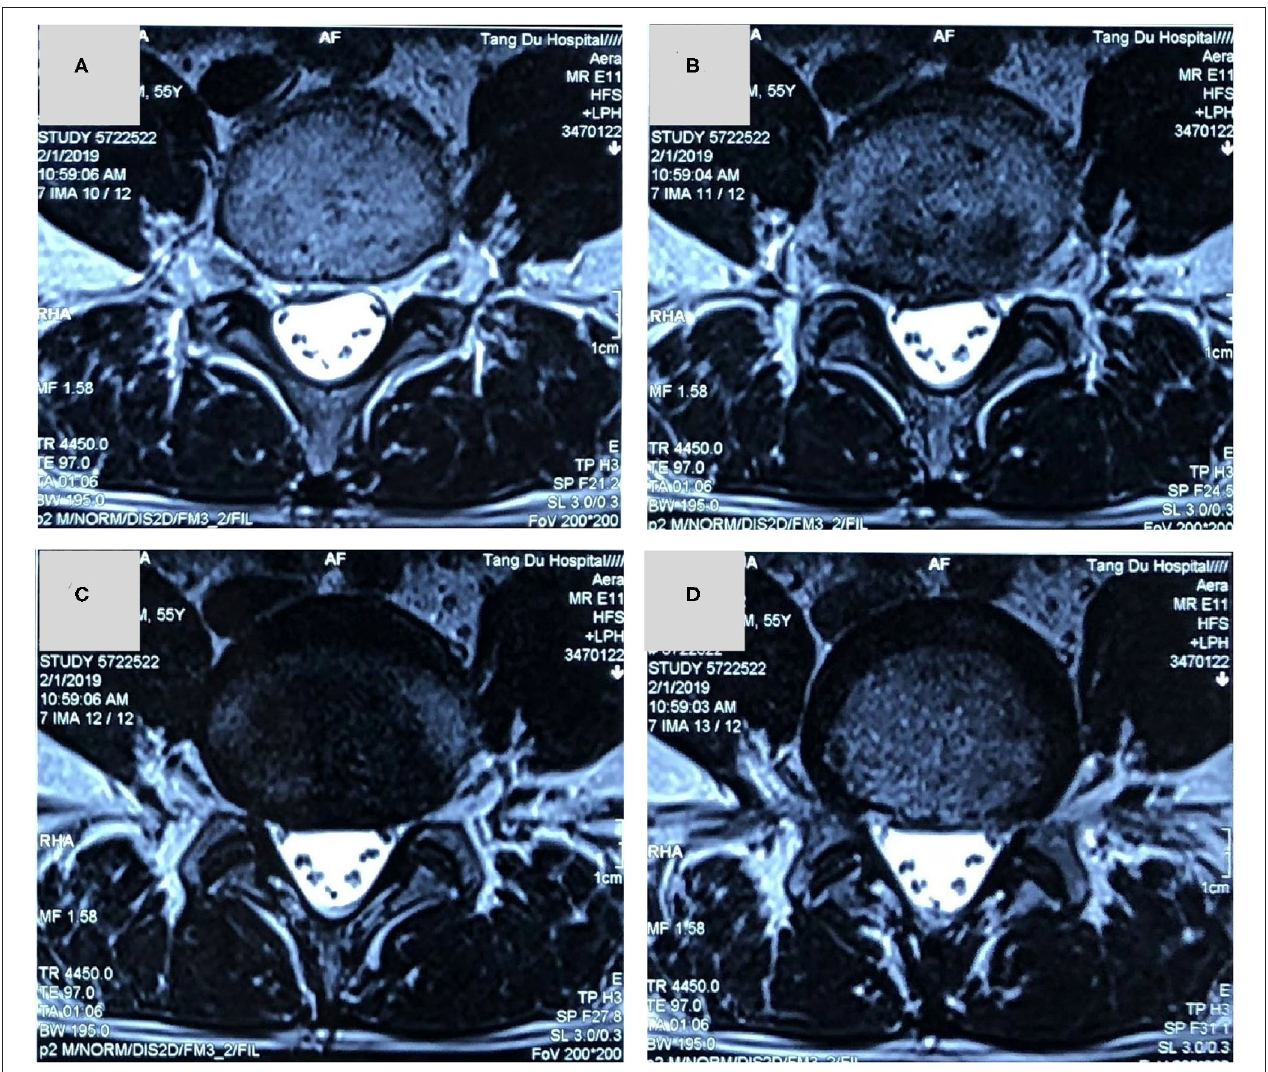
FIGURE 3 | (A–D) A magnetic resonance imaging in axial slice showed that a lateral type disc protrusion on the right side in L4/5 and the right lumbar 5th nerve was mildly compressed.